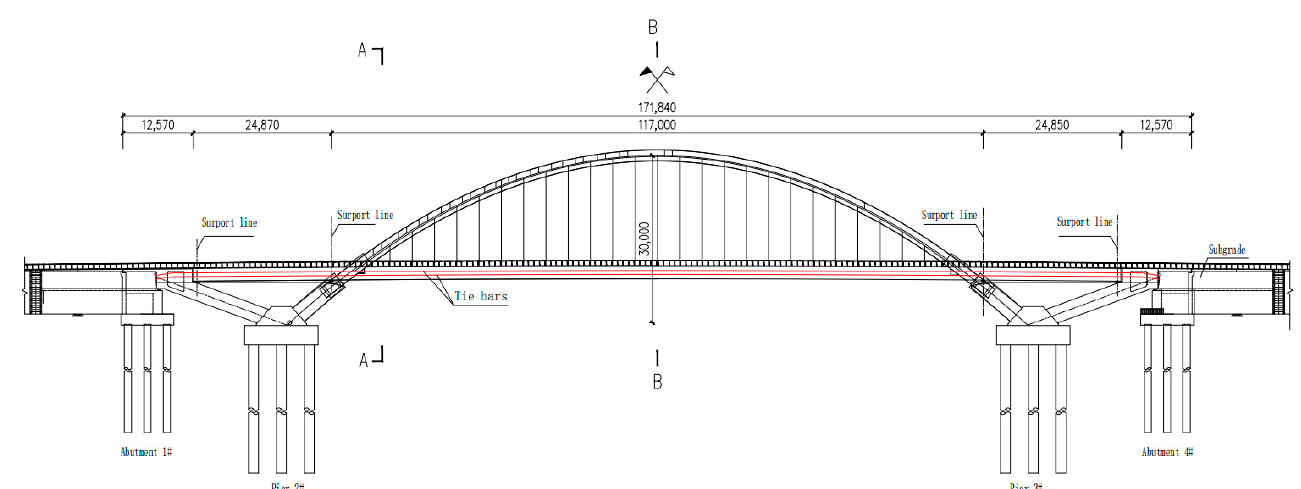
Figure 2. Bridge-type diagram of the bridge (unit: mm).